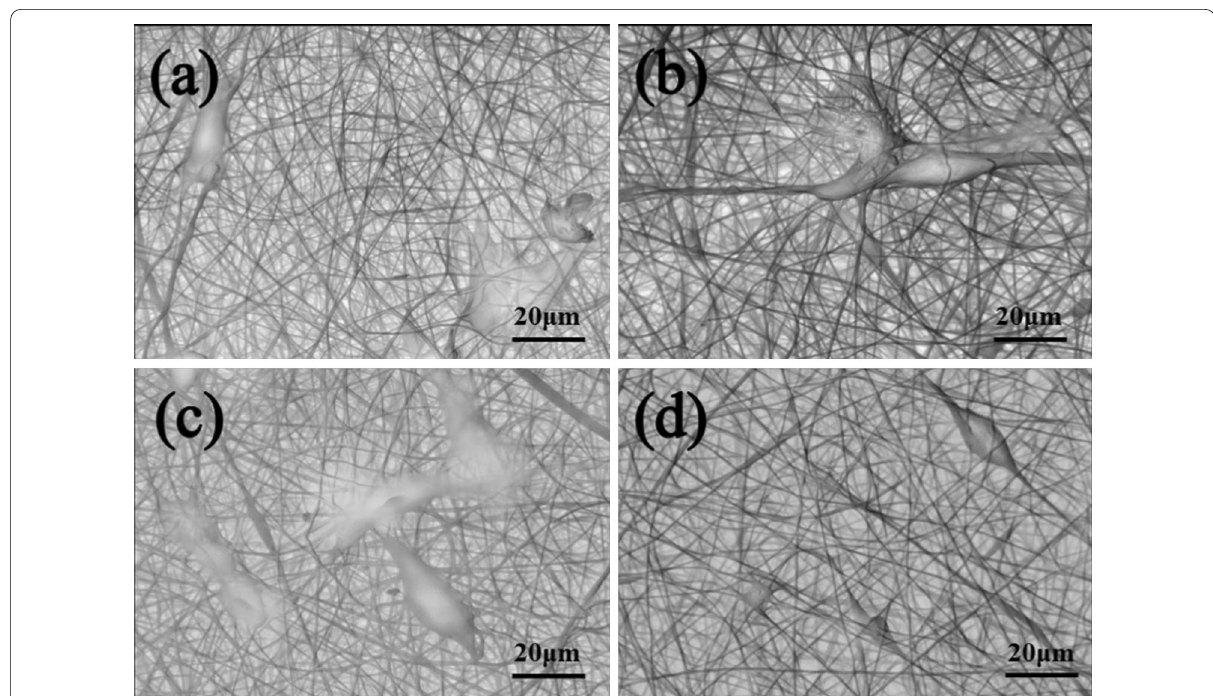
Fig.11 SEM micrographs of HOS seeded on a PLA nanofibers, b PANI/PLA-HA, c PANI/PLA-SA, and d PANI/PLA-PA composite nanofibers after 24 h